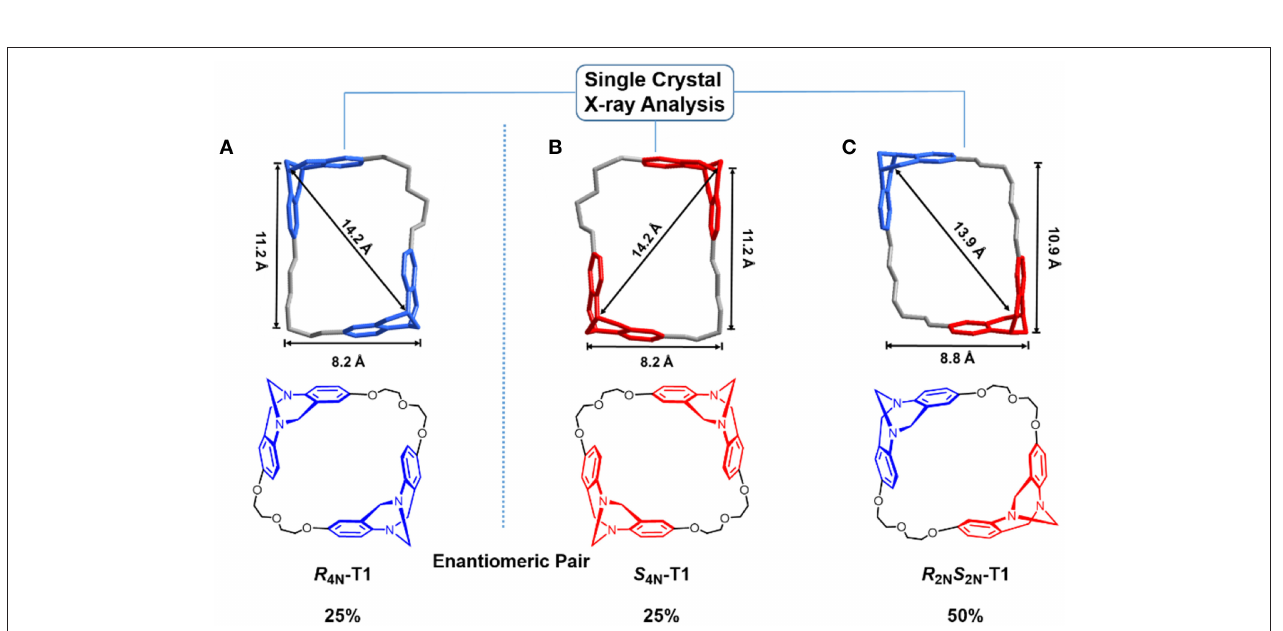
FIGURE 1 | (A) Resolution of stereoisomers of T1 by a chiral HPLC (fractions of S 4 N -T1 , R 2 N S 2 N -T1 , and R 4 N -T1 from left to right ). (B) CD spectra of S 4 N -T1 (0.01 mM , red ), R